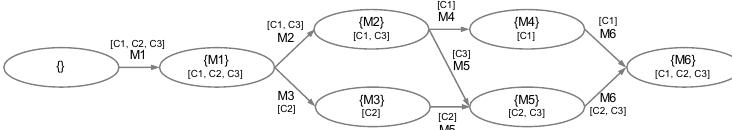
Figure Figure 3. An example of the case-annotated transition systems ( (cid:1845), (cid:1831), (cid:1846),(cid:1827) (cid:3046) ,(cid:1827) (cid:3032) ) with (cid:1870)(cid:1857)(cid:1868) (cid:3046) ((cid:2026)) = {(cid:2024) (cid:3028) ((cid:2026)(|(cid:2026)|))} and (cid:1870)(cid:1857)(cid:1868) (cid:3032) ((cid:1857)) = (cid:2024) (cid:3028) ((cid:1857)) based on the event log in Table 1.